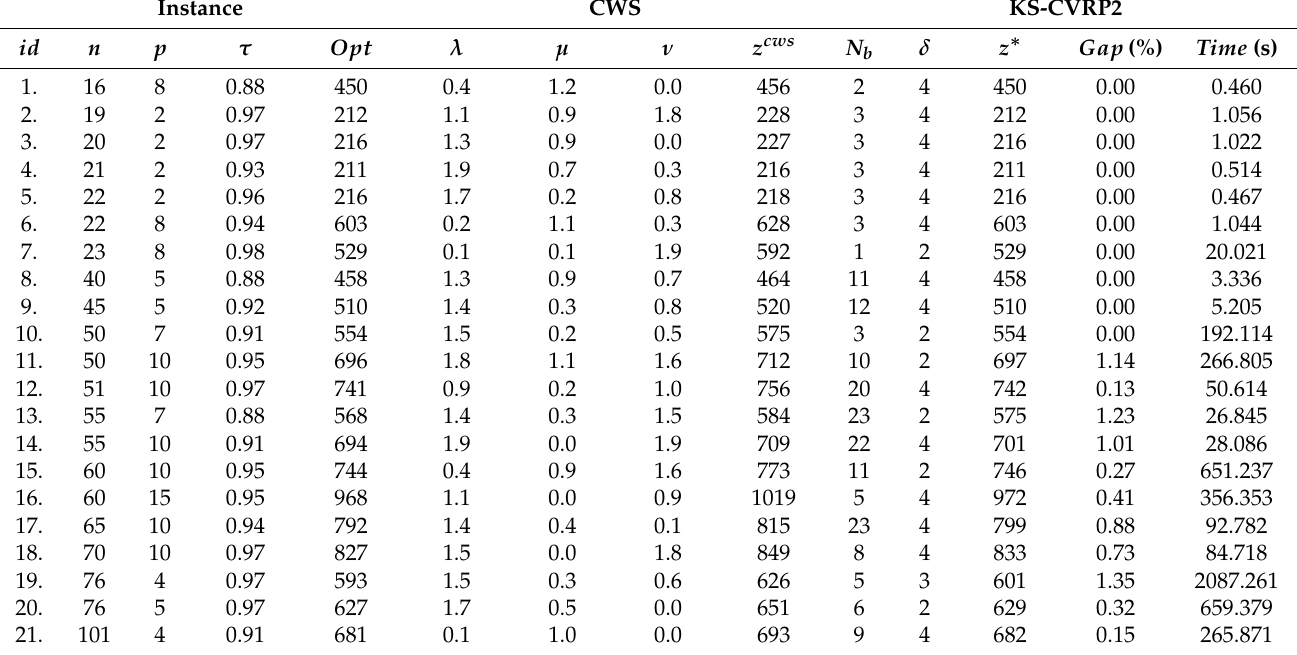
Table 2. Results for